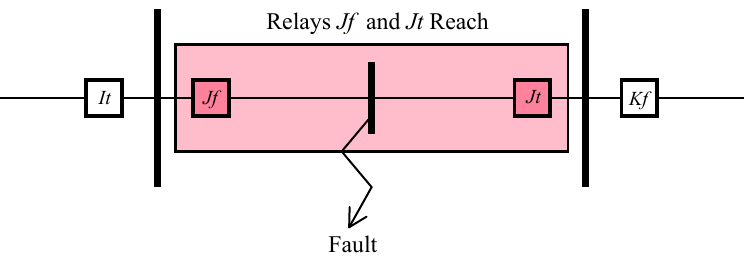
Figure 8. Oneline diagram for an ideal protection